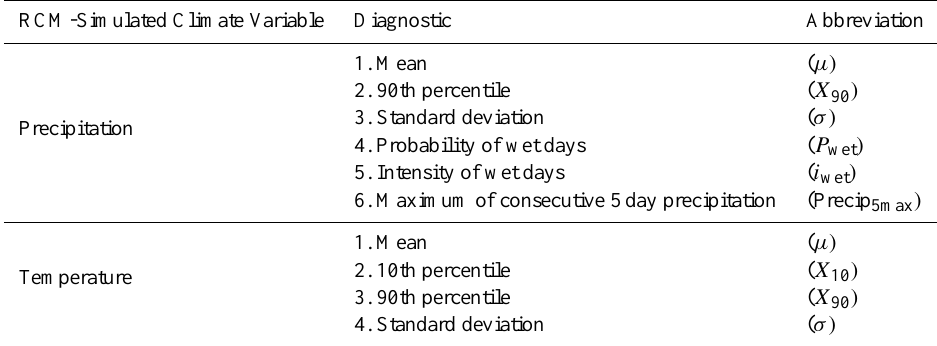
Fig. 3. Exemplary procedure of the differential split-sample test (DSST). First, the annual values (a) were sorted ascending (b, c) . For the twofold cross-validation, first the lower-value years were used for calibration and the higher-value years for validation. In a second step, calibration and validation periods were switched. This procedure was performed independently for precipitation and temperature. Table 5. Overview of diagnostics used to detect and estimate model errors in raw and corrected RCM-simulated precipitation and/or temper- ature